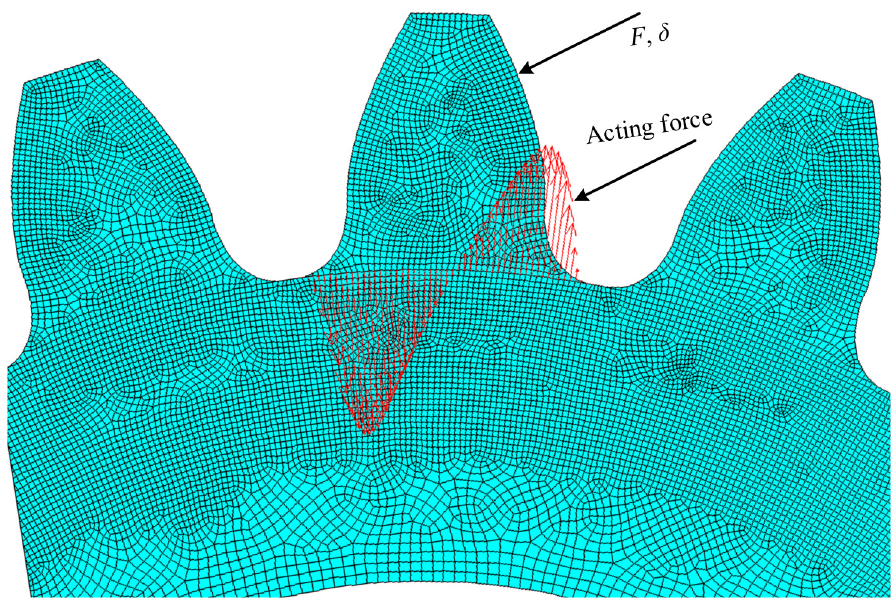
Figure 3. Illustration of acting forces on the tooth root.